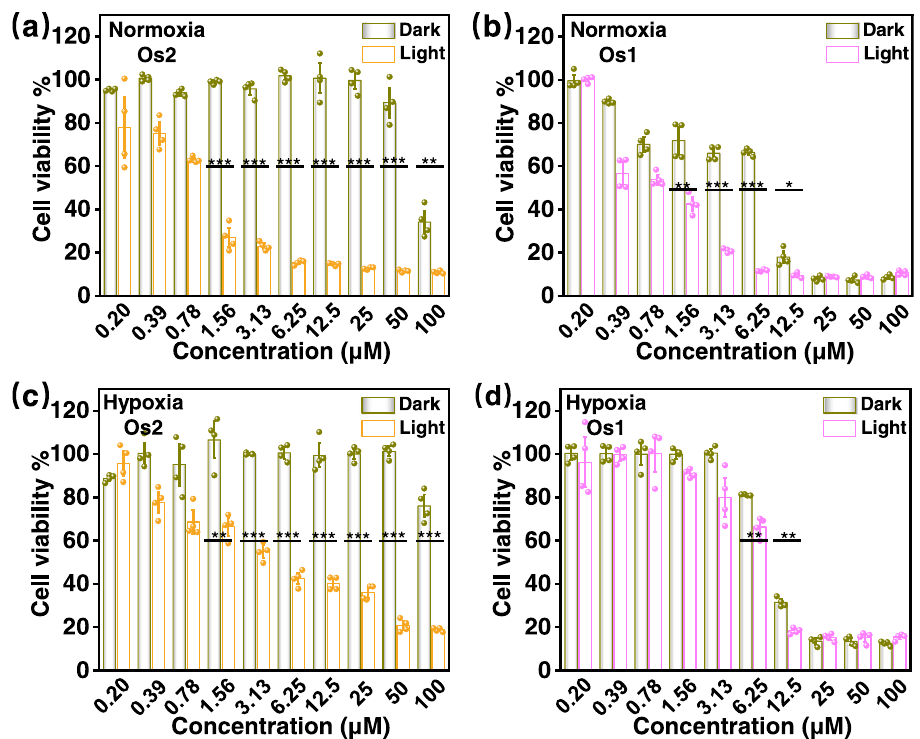
Fig. 4 Cytotoxicity against HeLa cells. The viabilities of HeLa cells treated with different concentrations of Os2 or Os1 under normoxia (20% O 2 , a , b ) or hypoxia (1% O 2 , c , d ) in the dark or upon light irradiation. All cell viability data was performed as duplicates of quadruplicate ( n = 4 biologically independent samples). Error bars represent S.D. from the mean. Statistical signi fi cance was calculated with two-tailed Student ’ s t test (* p < 0.05, ** p ≤ 0.01 or *** p ≤ 0.001). Incubation temperature: 310 K. Light irradiation: 465nm, 13 mW/cm 2 , 1 h. Table 1 The dark- and photo-IC 50 values of the compounds against HeLa cells under normoxia and hypoxia.